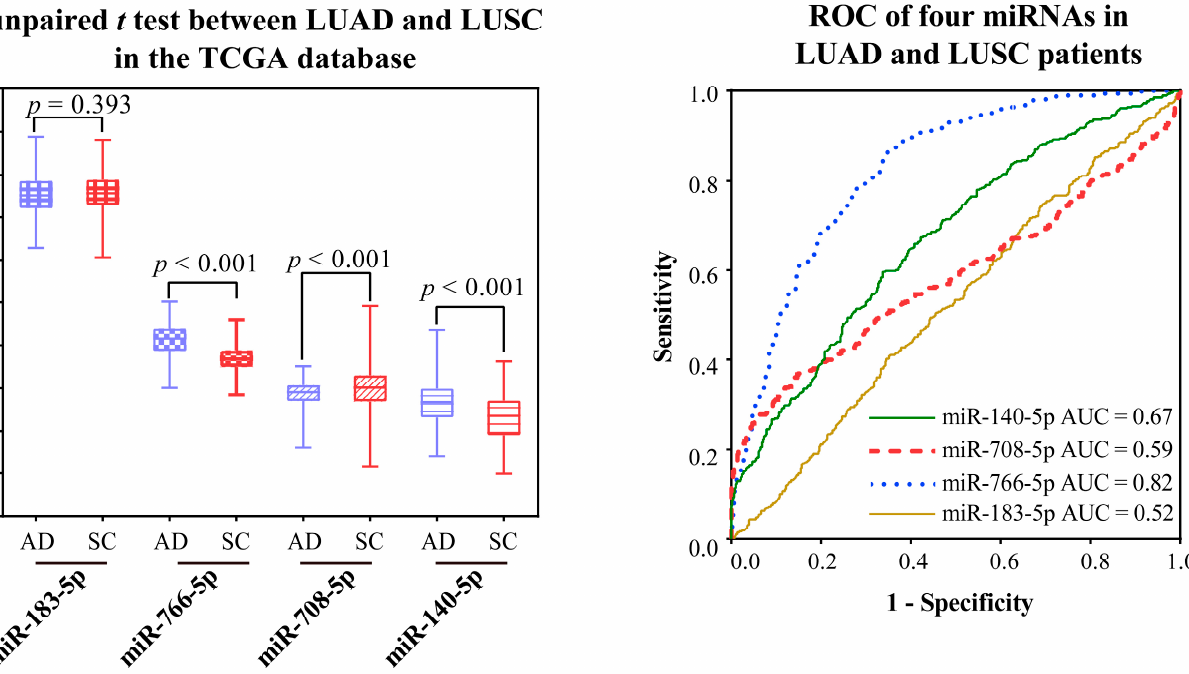
Figure 9. Expression and ROC curves of miRNA markers in LUAD and LUSC. The blue box indicates the normal samples, while the red box indicates the tumor samples.